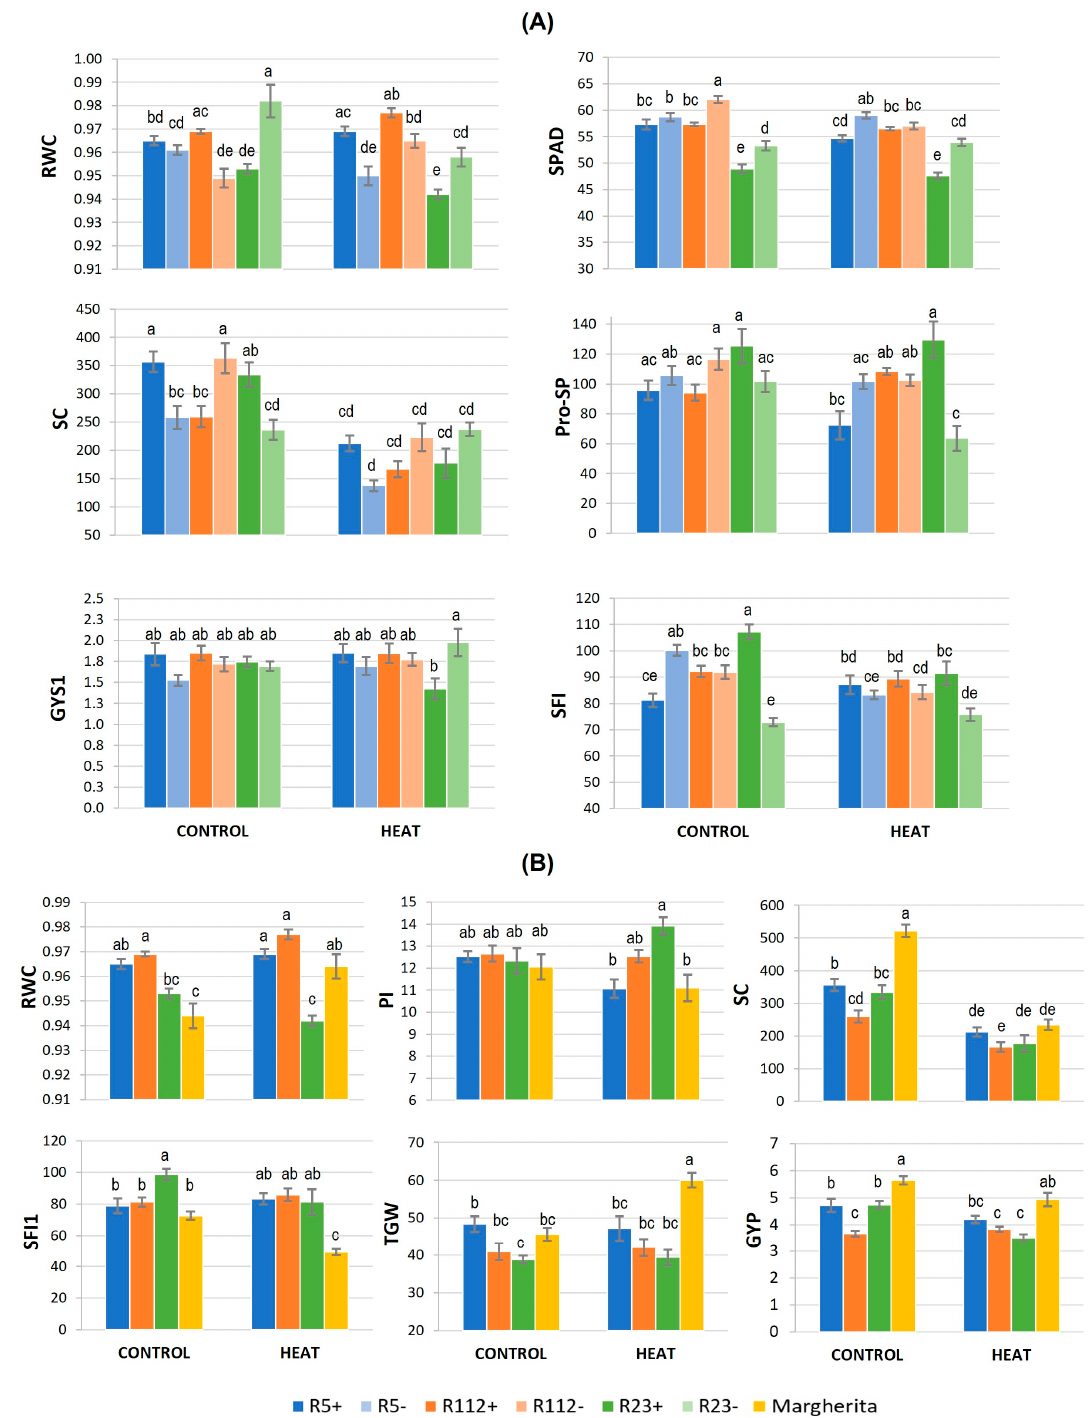
Figure 4. Significant genotype × treatment effects on physiological and yield-related parameters under 3-day heat stress: ( A ) comparison between alien segment carrier (+) and non-carrier ( − ) NIRLs, and ( B ) comparison between NIRLs+ and cv. Margherita. The error bars represent standard errors of the means, while the letters above histograms correspond to the ranking of Tukey HSD test at p < 0.05 significance level. For traits acronyms, see the Materials and Methods section.